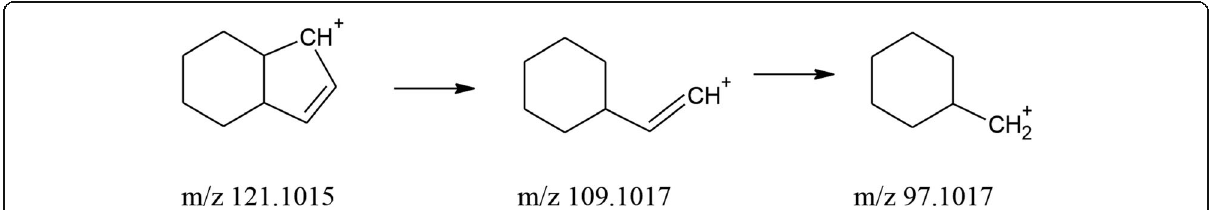
Fig. 6 Proposed chemical structure of compound 2 and its fragment ions with the respective exact